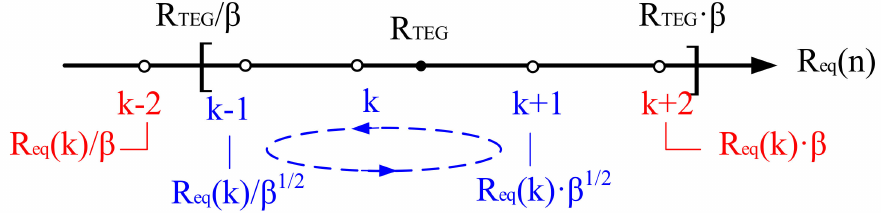
Figure 4. R eq ( n ) is a geometric sequence with a common ratio β 1/2 , and R eq ( k ) is one of the R eq ( n ) closest to R TEG .